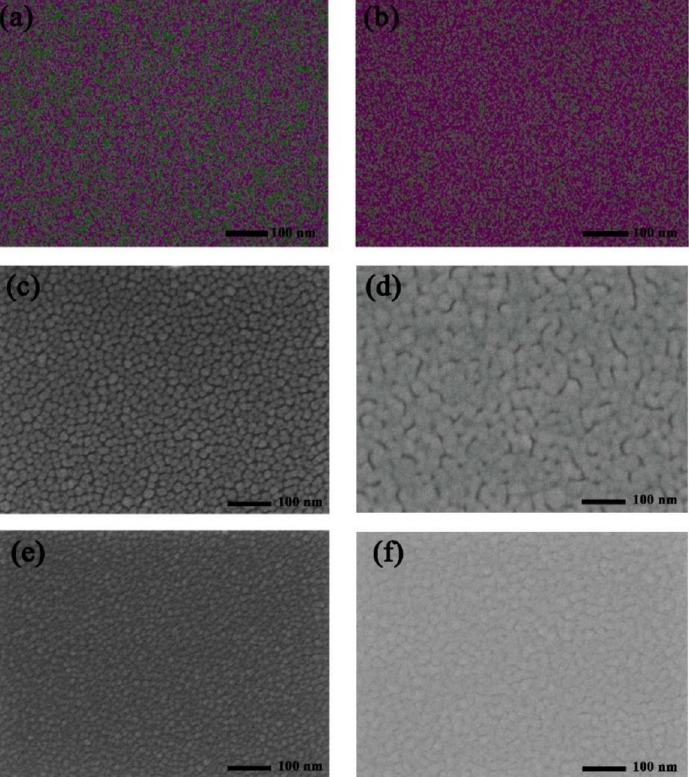
Figure 3. Elemental mapping of the elements Ag (red), Ge (green) in ( a ) the Ag/Ge film and ( b ) the Ag/Ge/Ag film. SEM images of the Ag films with structures of ( c ) MoO 3 /Ag (3 nm), ( d ) MoO 3 /Ag